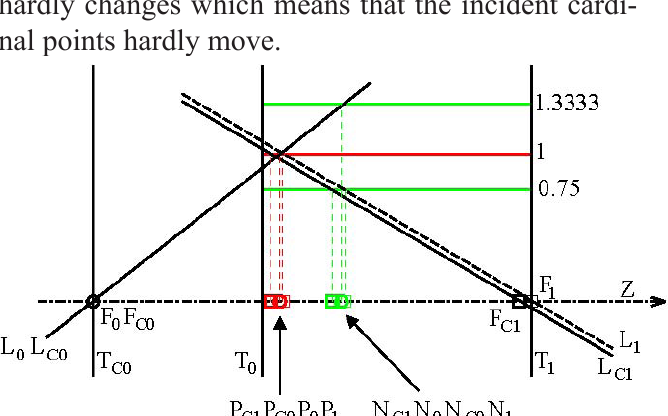
Figure 8 Locator lines and cardinal points for S, the visual sys- tem of the relaxed Gullstrand-Emsley eye, and for S C , system S with a thin lens of power 3 D at 15 mm in front of it. There is almost no change in incident locator and, hence, the incident special points undergo almost no shift. The emergent locator moves negatively with almost no change in slope and, hence, the emergent special points undergo a nearly uniform negative shift